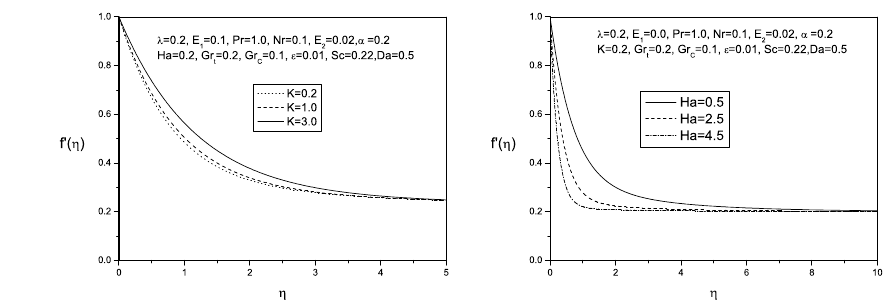
Figure 3. Variation of velocity profiles f (cid:48) with η for different values of Ha